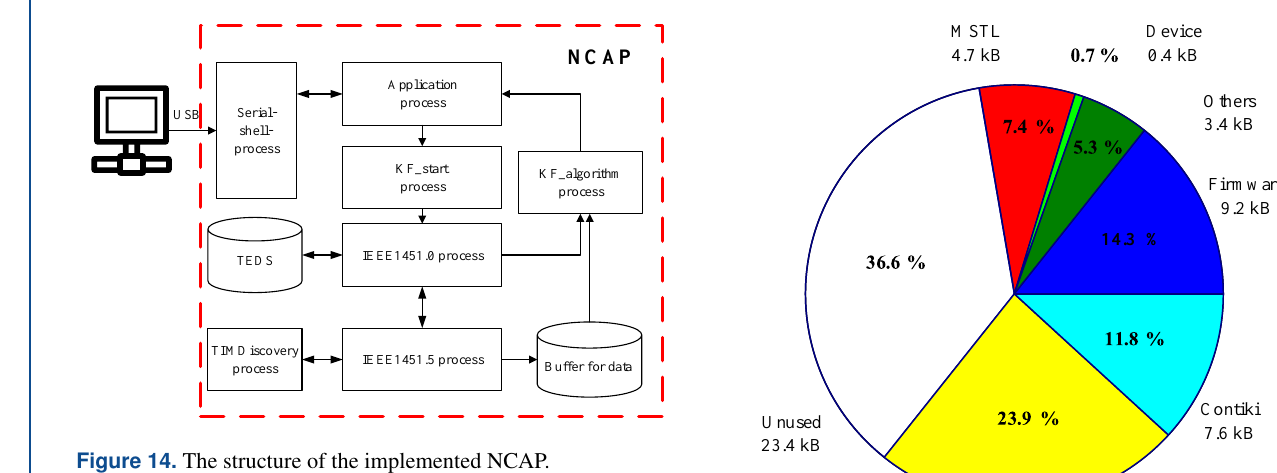
Figure 14. The structure of the implemented NCAP.